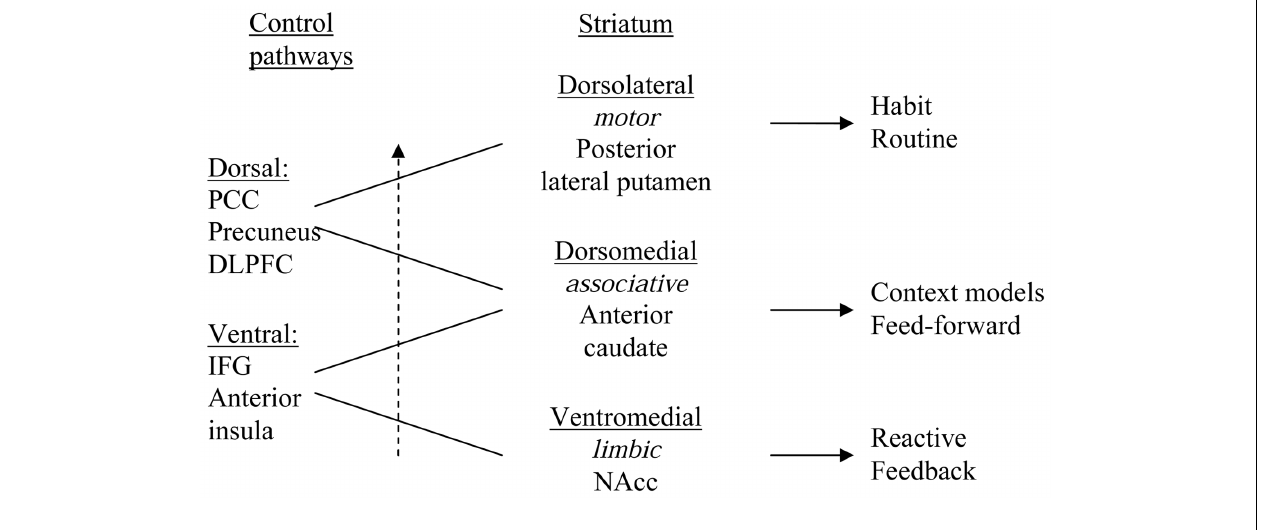
FIGURE 1 | Schematic representation of an interface between ventromedial (limbic), central/dorsomedial (associative), and dorsolateral (motor) striatal regions, via ventrolateral corticolimbic and dorsomedial corticostriatal control pathways and via the midbrain dopamine (DA) cells (ventral tegmental area and substantia nigra, not